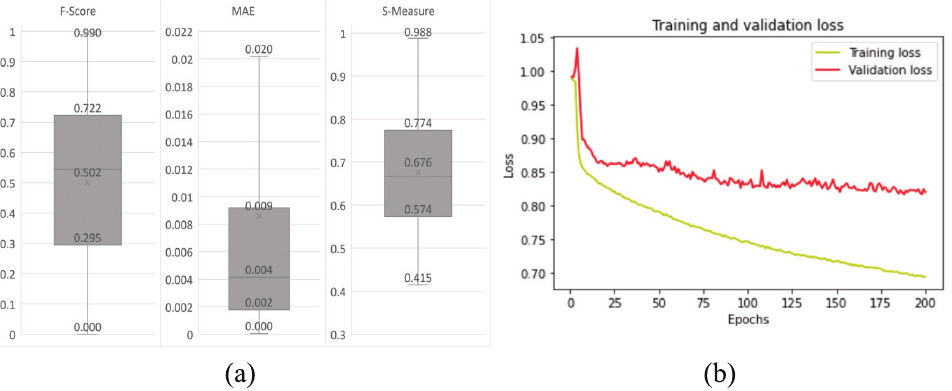
Figure 10. ( a ) A summary of the metrics over the entire dataset. ( b ) Training and validation losses after 200 epochs. The training was stopped after 200 epochs to avoid overfitting by the